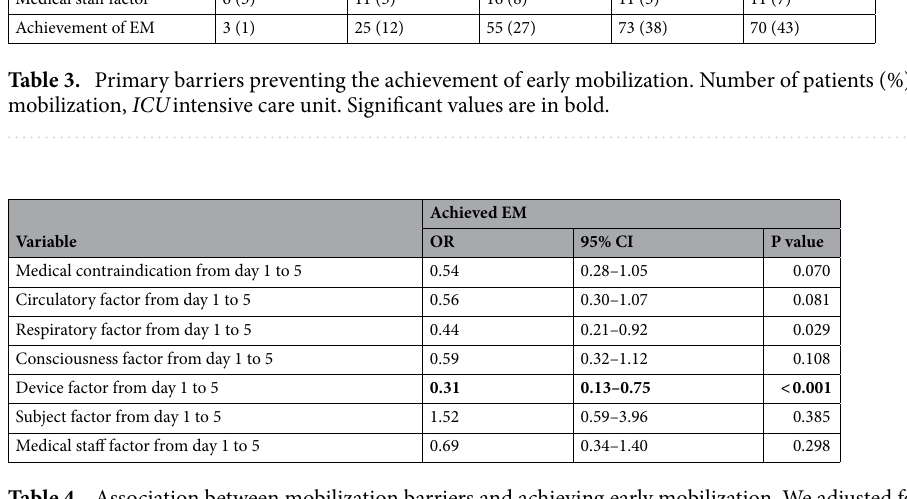
Table 4. Association between mobilization barriers and achieving early mobilization. We adjusted for multiple comparisons by using the Bonferroni correction and considered a result to be statistically significant if P < 0.007. OR odds ratio, CI confidence interval, EM early mobilization, ADL activity daily living, ICU intensive care unit. Significant values are in